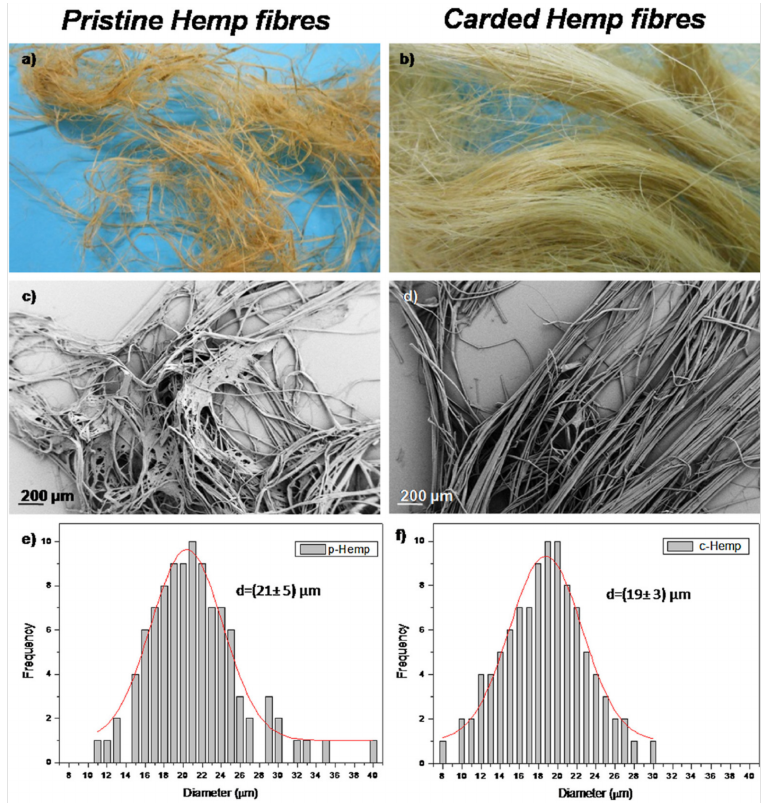
Figure 4. Optical images ( a , b ) and FESEM images ( c – f ) of diameter distribution of pristine and carded hemp fibres, respectively